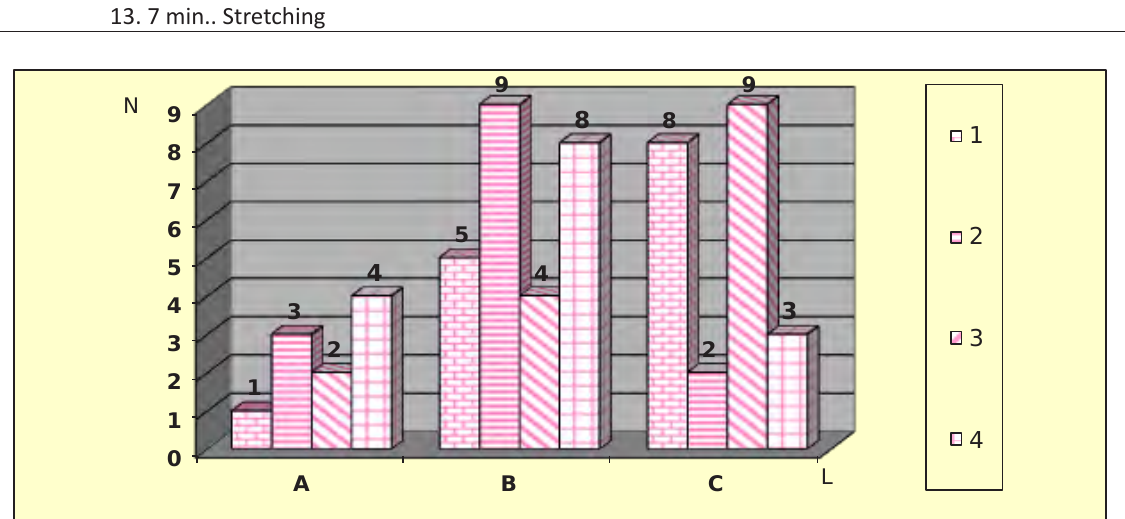
Fig.1. The results of the comparative analysis of EG and CG on the physical indicator: 1 – EG in the preliminary stage, 2 – EG – at the control stage, 3 – CG in the preliminary stage, 4 – CG – at the control stage, A – high level, B – average level, C – low level, D – level, N –